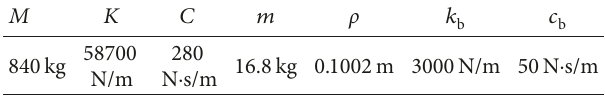
Table 1: Parameters of the PTRMD model.